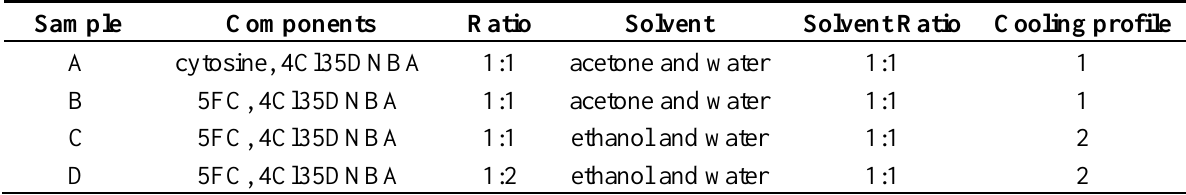
Table 1. Conditions of cooling crystallisations using a ReactArray Reaction